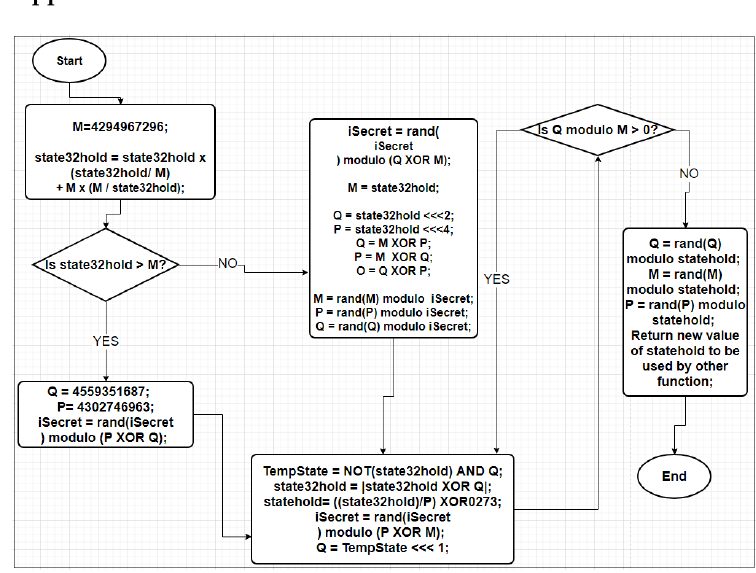
Figure A1. Flowchart of a Blocker